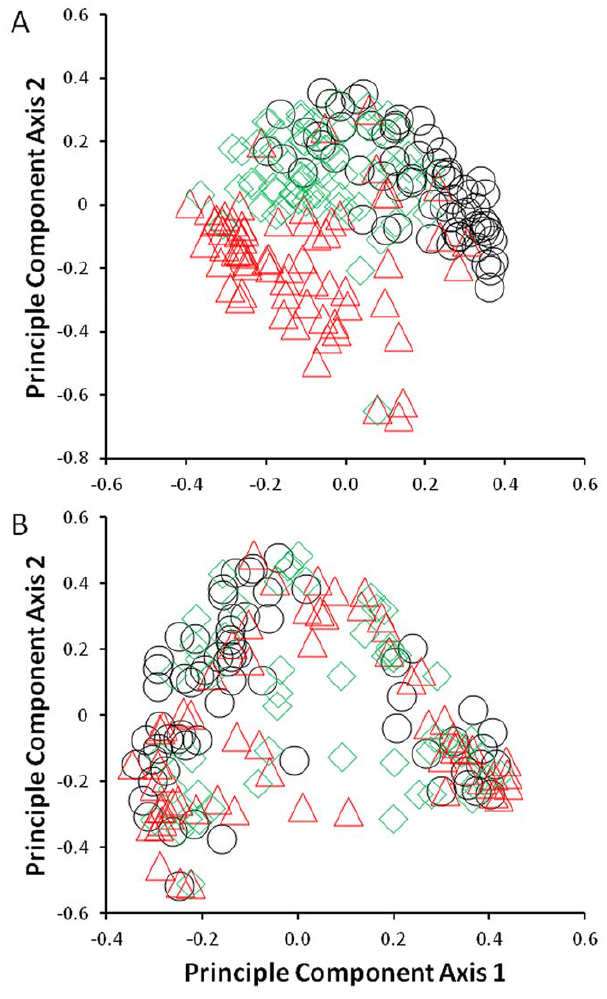
Figure 3. Variability in assemblage structure among years at both scales. Scores of PC1 and PC2 of each station from 2002 (circles), 2003 (triangles), and 2004 (diamonds) are shown for the (A) CCA and (B) CalCofi scales. See Table 2 for taxa loadings on each axis.